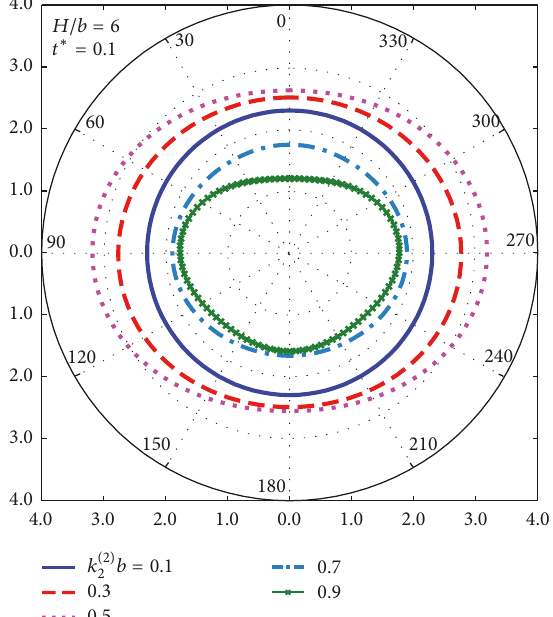
Figure 5: Tangential stress (𝜎 ∗ 𝜃𝜃 ) versus polar angle at 𝑟 = 𝑏 for different wave numbers (𝑘 (2) 2 𝑏) for a tunnel in hard soil.